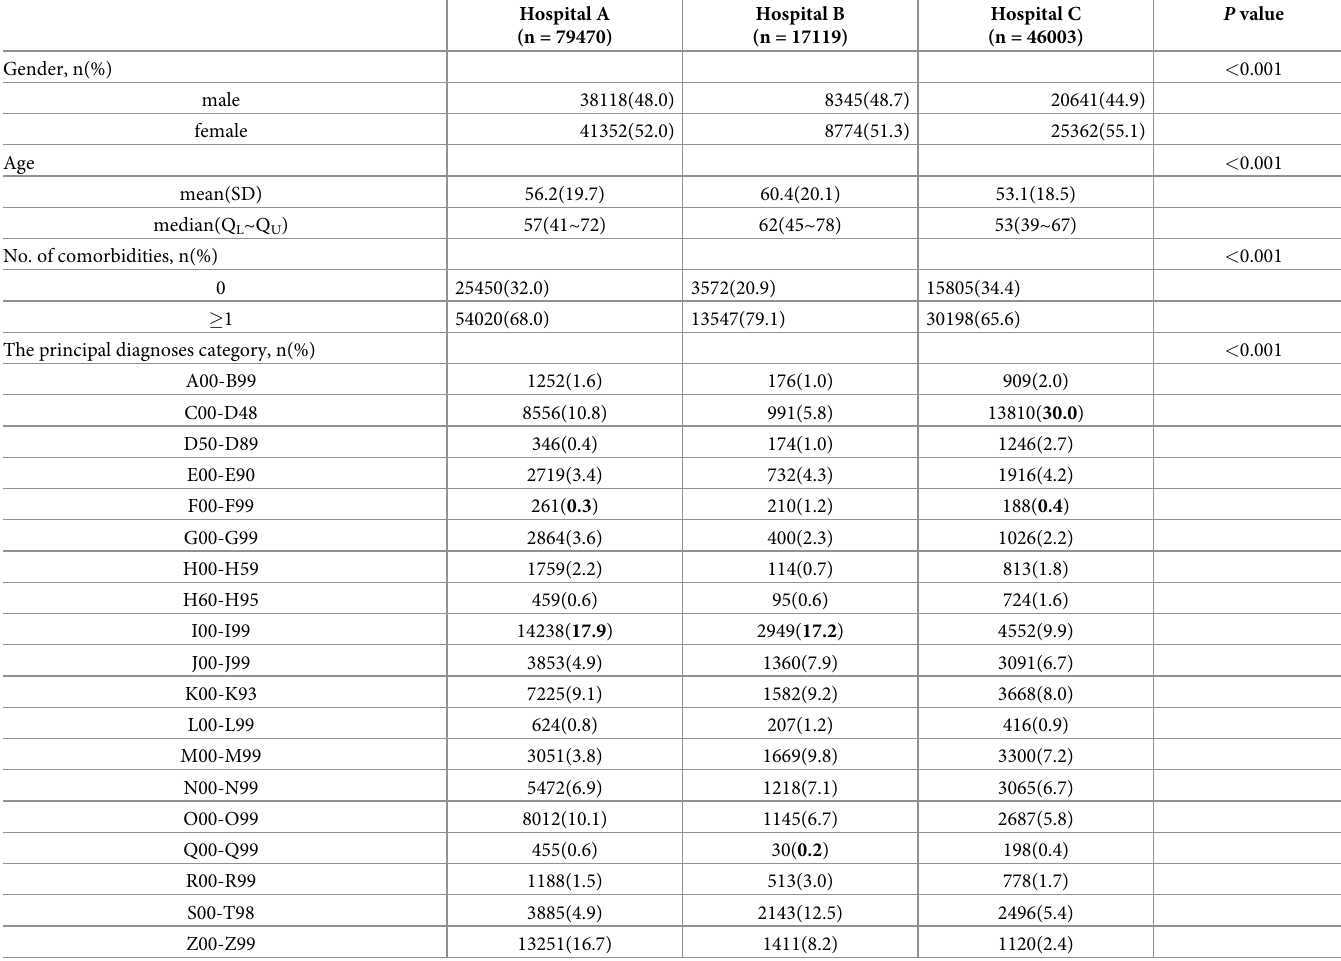
Table 4. Characteristics of discharges among three